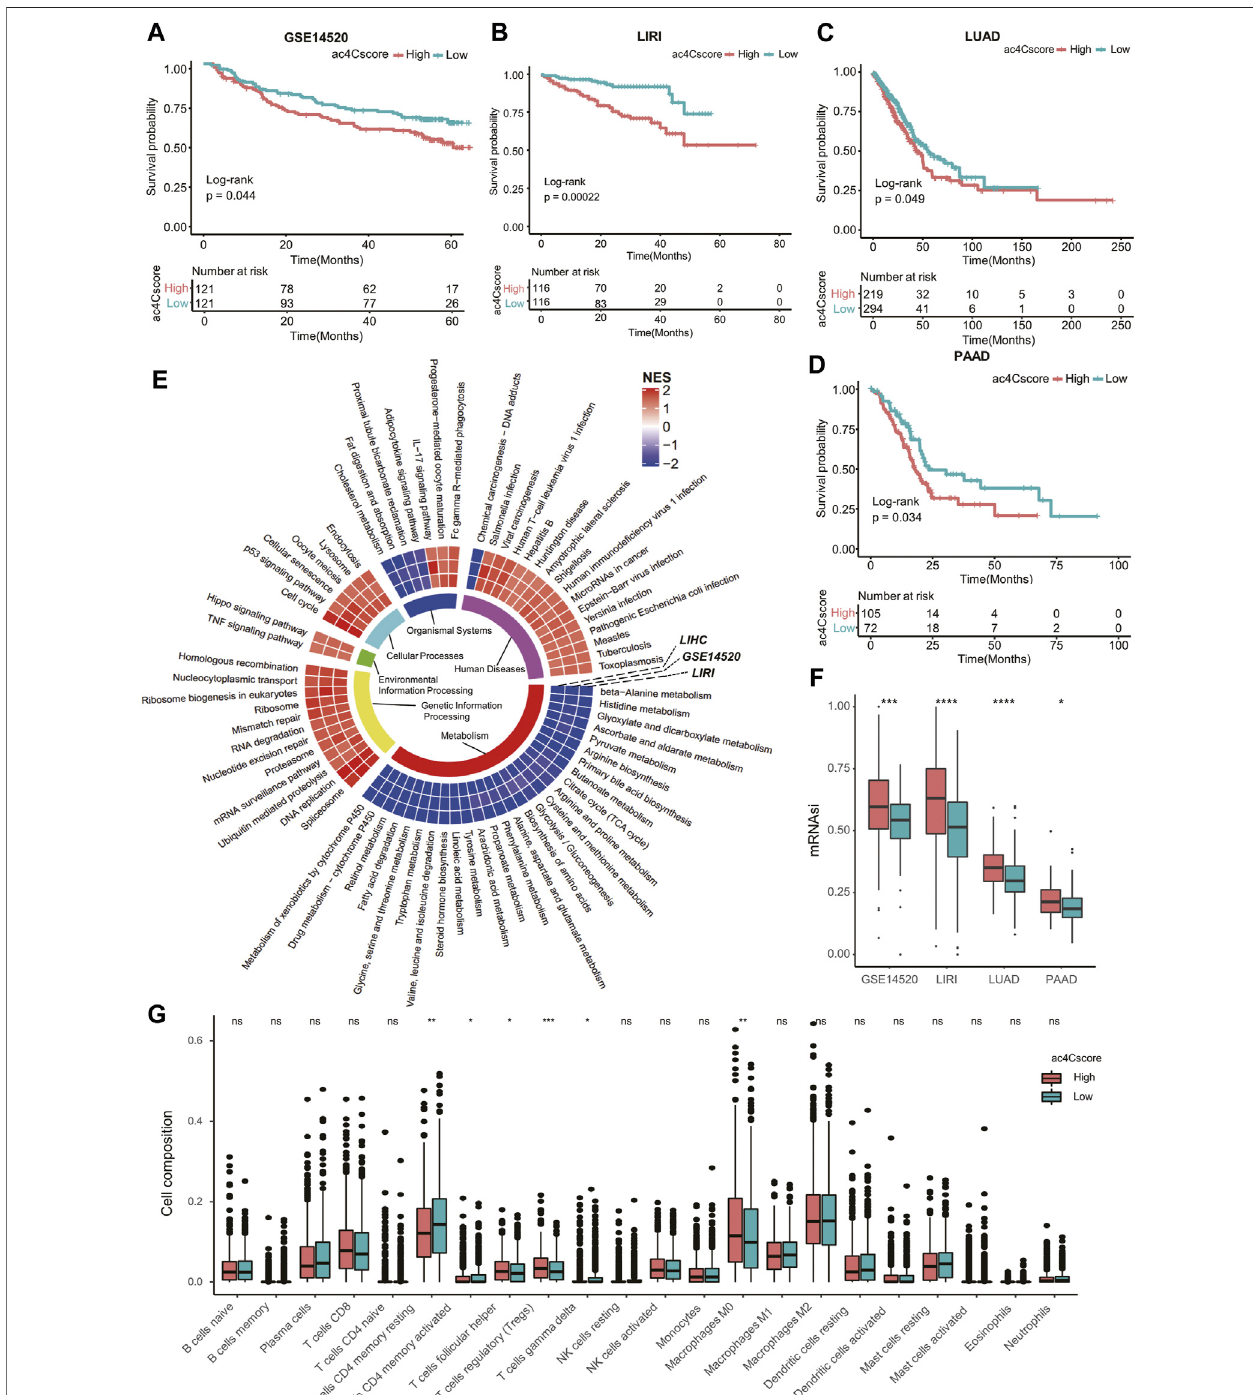
FIGURE 6 | ac4Cscore is a common predictive marker in other datasets. (A – D) Survival analysis of the ac4Cscore groups in GSE14520, LIRI, LUAD and PAAD. Kaplan-Meier curves with log-rank p values < 0.05 are considered signi fi cant. (E) Ring heatmap of GSEA-based KEGG pathway analysis between the ac4Cscore-high and ac4Cscore-low groups. The inner most ring annotates pathway categories. Cells in the outer rings are colored by normalized enrichment score (NES) calculated by GSEA. A higher NES means higher pathway activity in the ac4Cscore-high group. Only pathways that showed consistent results in three HCC datasets are extracted and visualized. (F) The mRNAsi values for ac4Cscore high and low groups in GSE14520, LIRI, LUAD and PAAD. Dots represent the outliers. (G) The distribution of22 immunecell types for the four ac4Cscore groups. Wilcoxon test is used for statistical analysis. * p < 0.05, ** p < 0.01, *** p < 0.001, **** p < 0.0001and ns means not signi fi